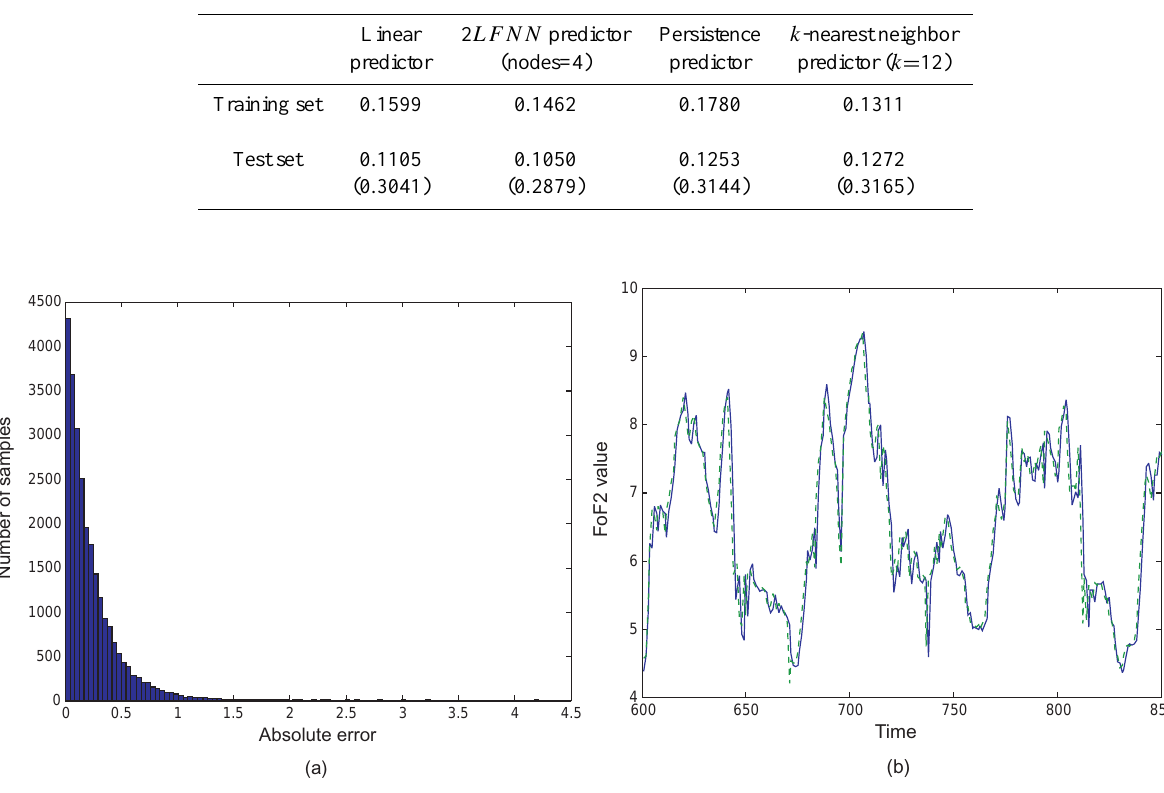
interval, are given for each of the four predictors. It is